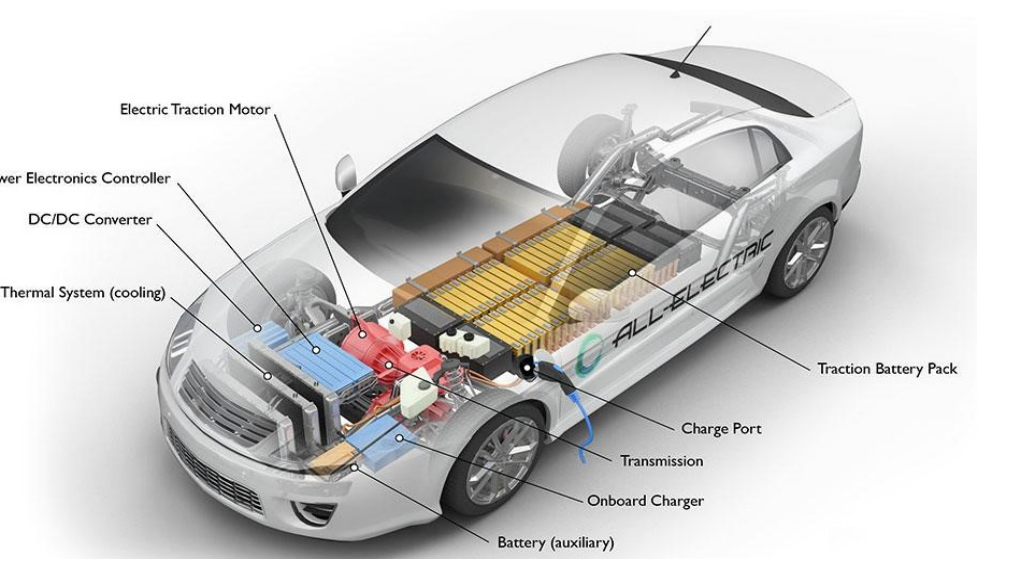
Figure 5. Pure electric vehicle [29].